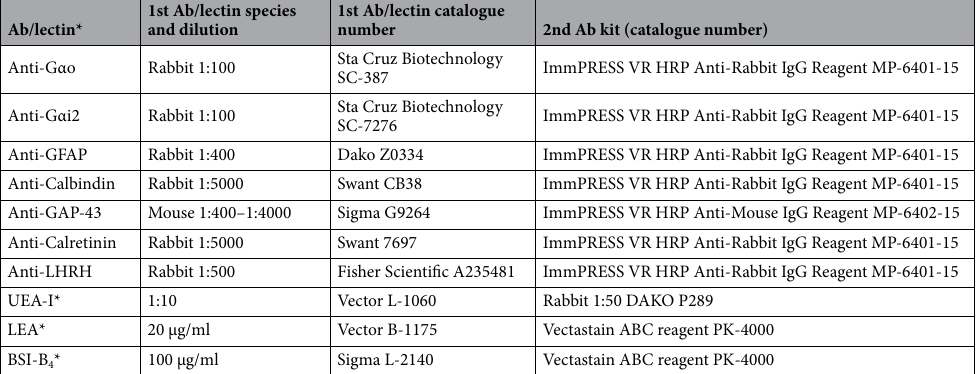
Table 1. Antibodies and lectins used, with species of elaboration, dilution, manufacturer, and catalogue number. Gαo: subunit αo of G protein; Gαi2: subunit αi2 of G protein; OMP: olfactory marker protein; MAP-2: microtubule associated protein-2; GAP-43: growth-associated protein 43; GFAP: glial fibrillary acidic protein; CB: calbindin; CR: calretinin; LHRH: luteinizing hormone-releasing hormone; UEA: Ulex europaeus agglutinin; LEA: Lycopersicum esculentum agglutinin; BSI-B 4 : Bandeiraea simplicifolia isolectin B 4 ; HRP: horseradish peroxidase; IgG: Immunoglobulin G; ABC: avidin–biotin-complex. The lectins employed are indicated by an asterisk